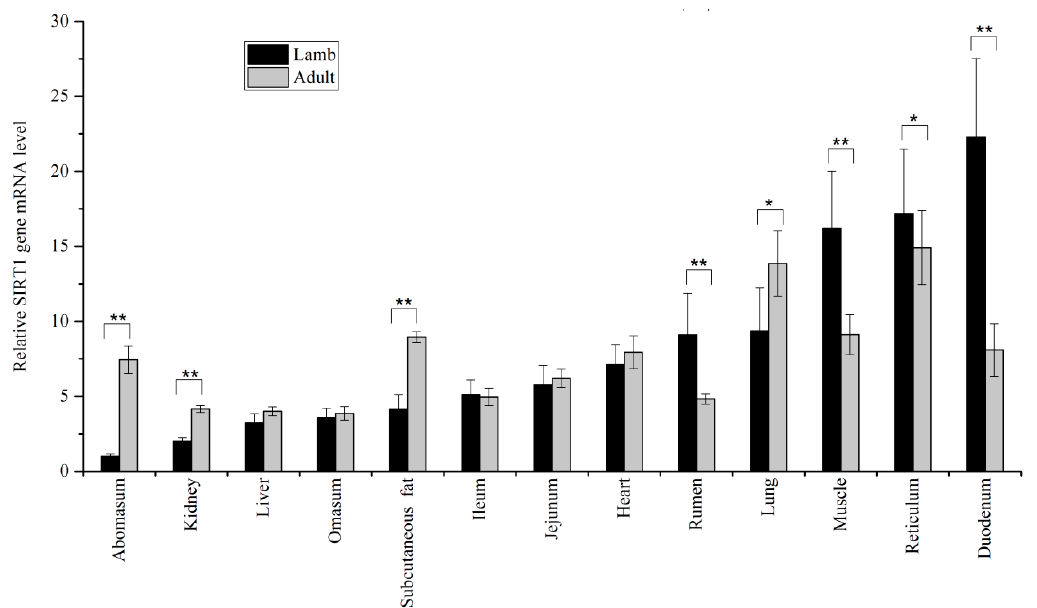
Figure 1. The relative mRNA expression of ovine SIRT1 . * p < 0.05, ** p < 0.01.